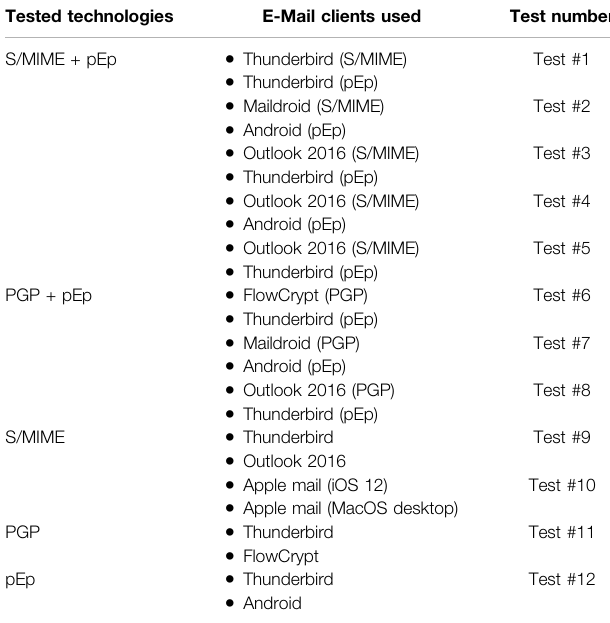
TABLE 2 | Test scenarios and mail user agents tested by the users. Tested